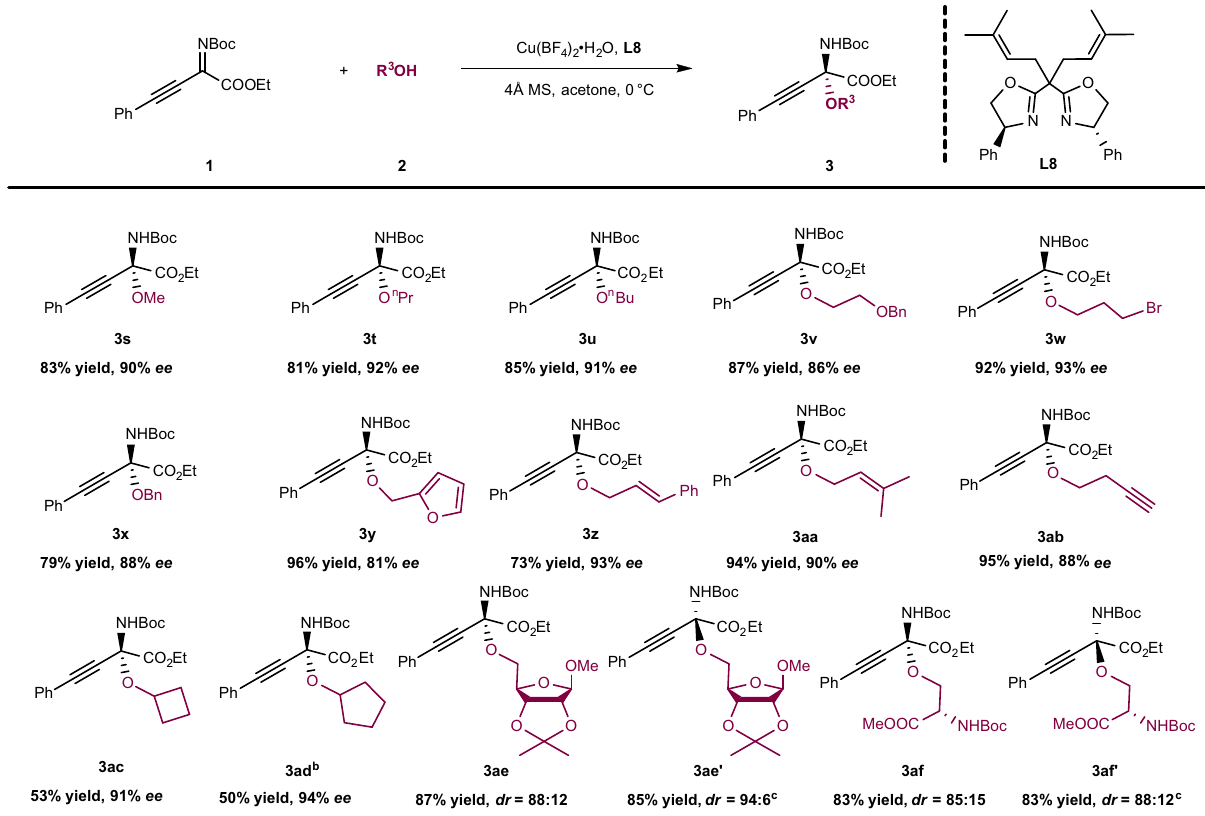
Fig. 4 Scope of alcohols. Reaction conditions: 1 (0.10 mmol), 2 (0.20 mmol), Cu(BF 4 ) 2 ∙ H 2 O (10 mol%), L8 (15 mol%), 4 Å MS (40 mg), acetone (1.0 ml), 0 °C, 24 h; the yield refers to isolated yield; the ee value was determined by HPLC. a 5.0 Equiv. alcohols was used and it was reacted for 48 h. b Ligand ent - L8 was used instead of L8